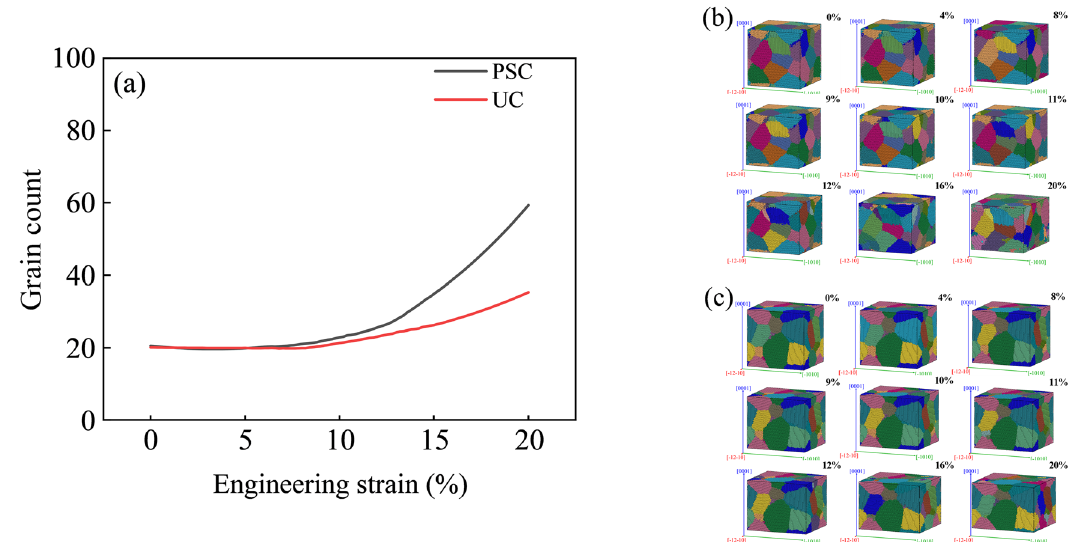
Figure 3: Grain change: ( a ) grain number curve, ( b ) grain change under PSC, and ( c ) grain change under UC.